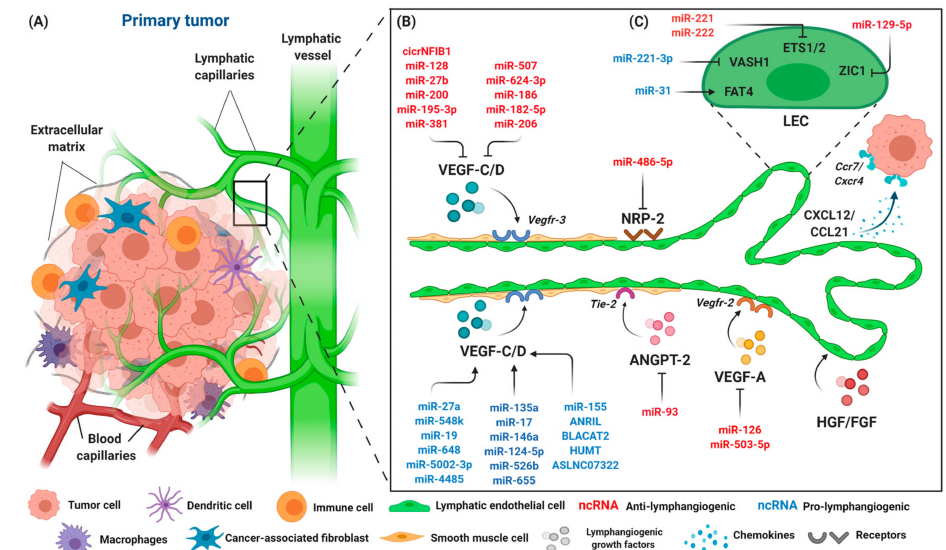
Figure 3. The components of the primary tumor microenvironment and lymphangiogenic factors involved in tumor progression. ( A ) Tumor cells are surrounded by an abundance of cell types, such as immune cells, macrophages, dendritic cells, fibroblasts, and endothelial cells. Blood and lymphatic capillaries are required to support the growth of the tumor, while serving as a conduit for the dissemination of tumor cells to distant organs. ( B ) Lymphangiogenesis occurs during tumor progression with lymphangiogenic factors released by tumor cells, namely VEGF-C / D, VEGF-A, NRP-2, ANGPT-2, and HGH / FGF. Tumor cells that expressed chemokine receptors CXCR4 are attracted to inflammatory chemokines CCL21 / CXCL21 released by LECs, and thus stimulate lymphangiogenesis. The interaction of LECs with lymphangiogenic factors results in an increase of lymphatic permeability by changing the adhesion properties of LECs, accompanied by the dilation of collecting lymphatic vessels to facilitate the spread of tumor cells through intratumoral and peritumoral lymphangiogenesis, finally leading to lymphatic metastasis. A number of di ff erent ncRNAs are expressed throughout the process. ncRNAs exert their pro- (blue) or anti-lymphangiogenic (red) e ff ect by regulating primary lymphangiogenic components. ( C ) Regulation of tumor-associated lymphangiogenesis by ncRNAs also occurs on LEC transcription factors, such as protocadherin Fat4 (FAT4), vasohibin-1 (VASH1), Ets